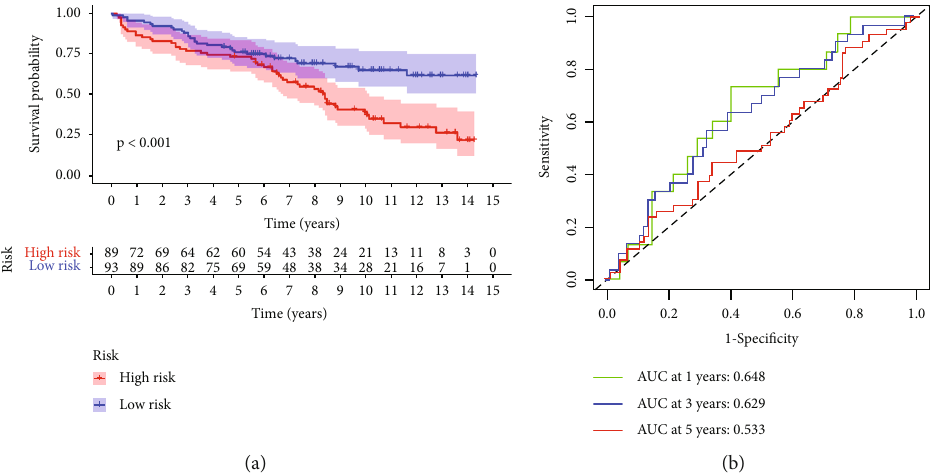
Figure 4: Veri fi cation of the prognostic characteristics of OS-related ARGs in the validation set. (a) Kaplan – Meier curve for validation of the prognostic features in the validation set. (b) ROC curve for forecasting OS over one, three, and fi ve years in the validation set.